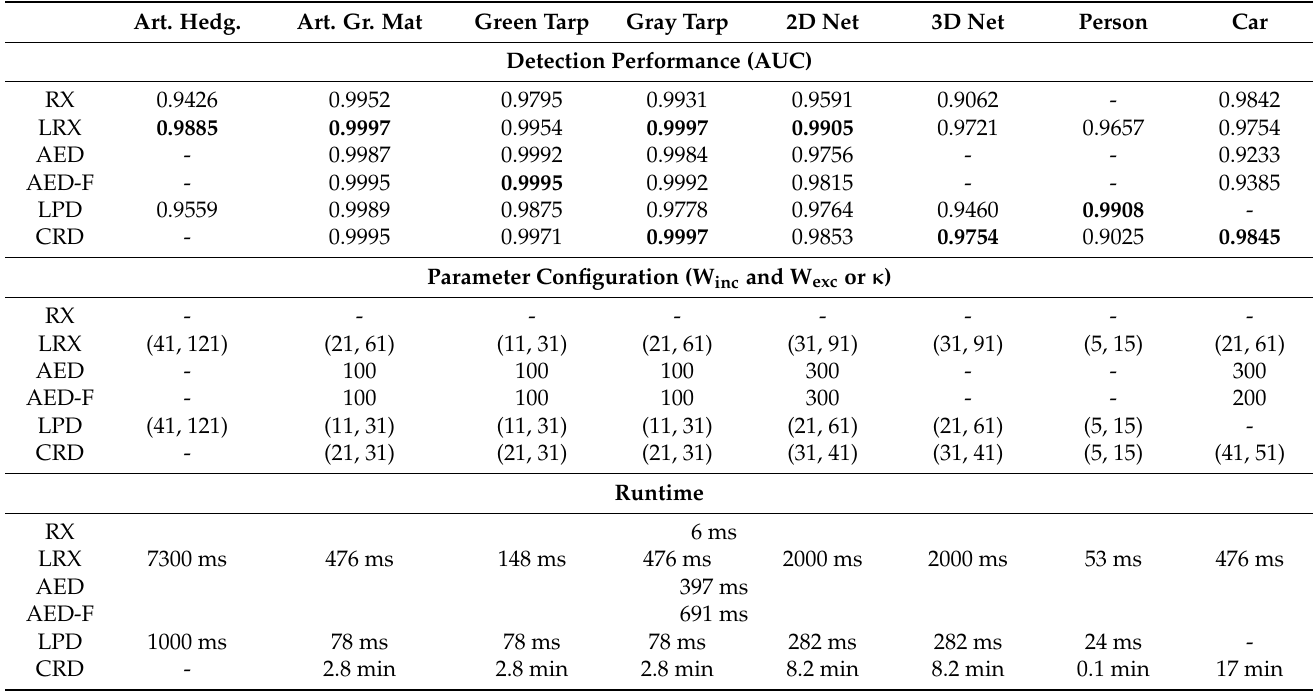
Table 4. Class-wise detection performances, parameter configurations, and runtimes of each method applied on MUCAD extended by vegetation indices (MUCAD-VI). Detection results with an AUC less than 0.9 were replaced with a “-” for better